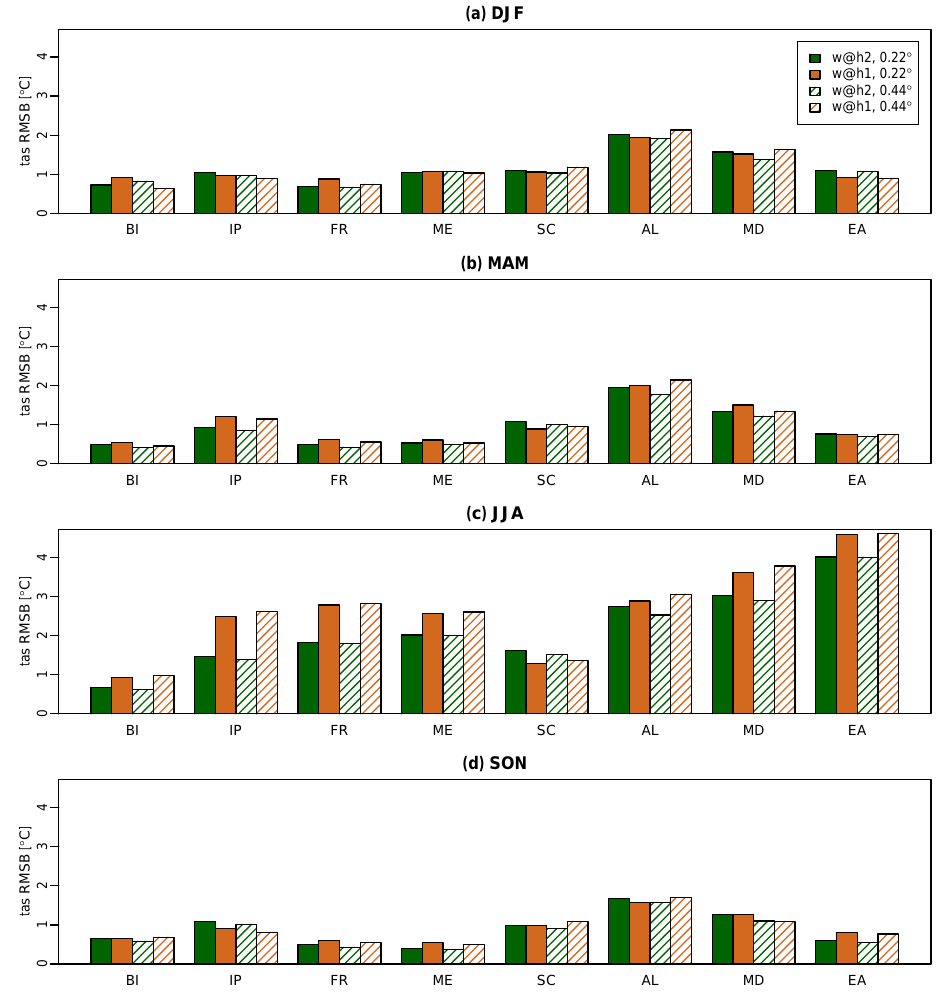
Figure 7. Spatial root mean squared biases in surface air temperature by region and season with respect to the E-OBS dataset. The regions are shown in Fig. 1. Green (orange) bars are for w@h2 (w@h1); filled (hatched) bars are in comparison with E-OBS at 0 . 22 ◦ (0 . 44 ◦ )